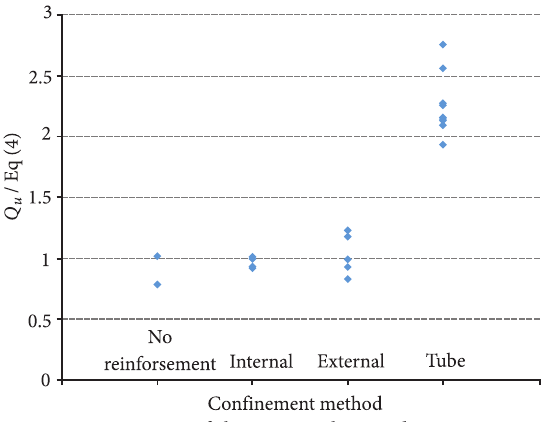
Fig. 10. Comparisons of shear strength according to confinement methods